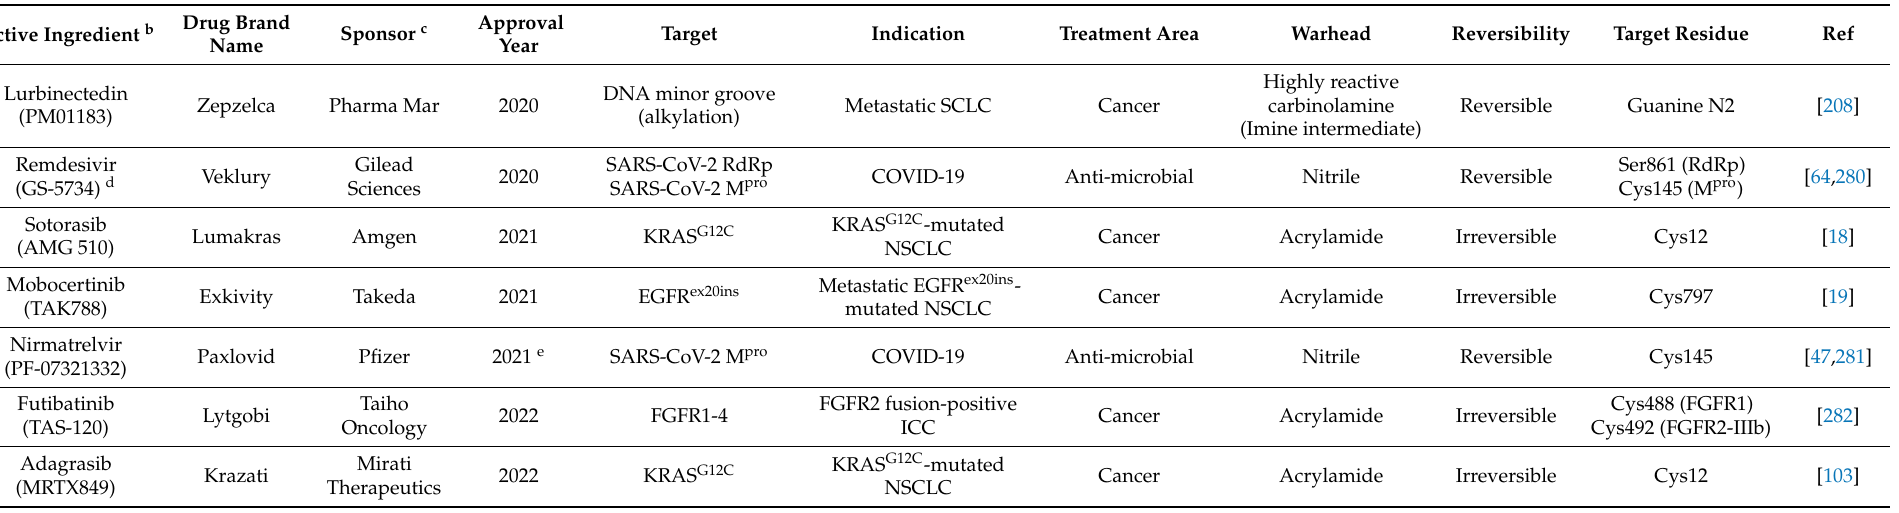
Table A1. FDA approved drugs (2020–2022) with a known covalent mechanism of action a